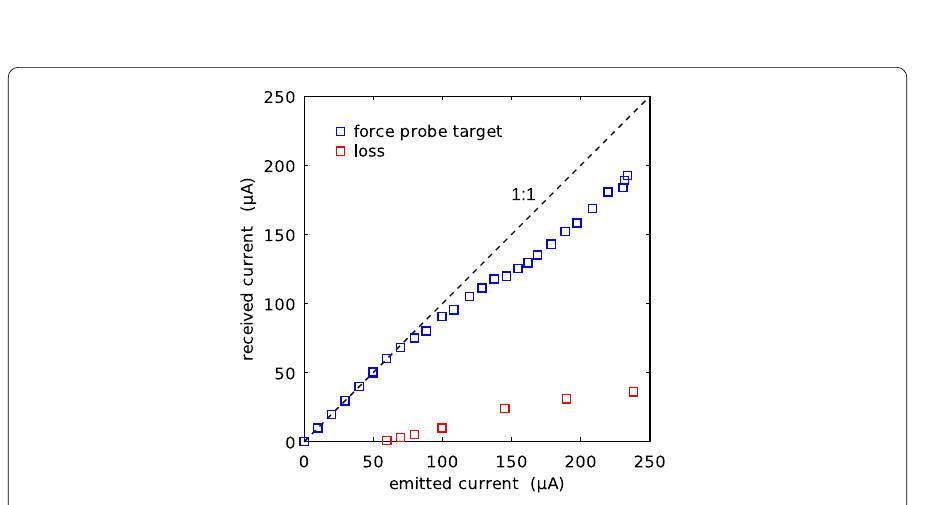
Figure 10 FEEP emitter current, force probe target current, and the current measured at the beam dump and the chamber walls. The latter obviously stem from ions that missed the